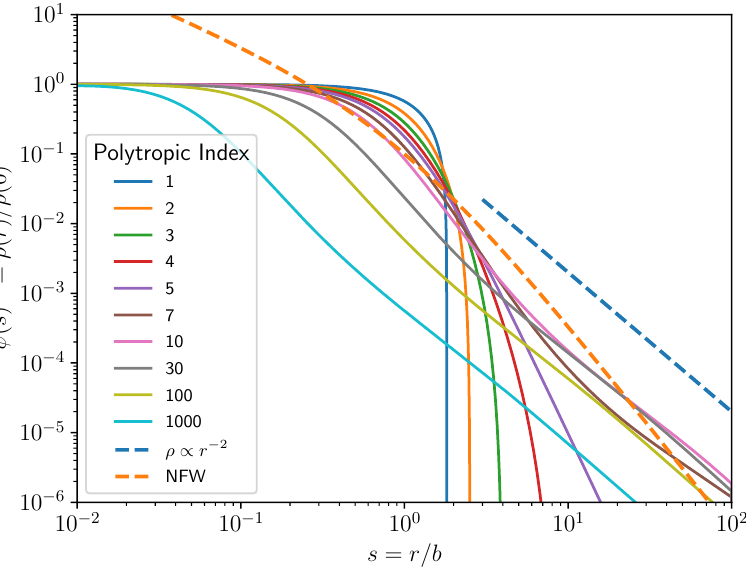
Figure 1. Polytropes resulting from solving the Lane–Emden Equation (21). These curves just provide the shape of the mass density profile, which can be shifted horizontally and vertically by arbitrary amounts (set by the constants b and ρ ( 0 ) , respectively). The color code of the solid lines gives the polytropic index m as indicated in the inset. The curve with m = 1000 approximately corresponds to the shape of an isothermal sphere. For reference, the figure includes ρ ∝ r − 2 (the blue dashed line), which represents the asymptotic behavior of high- m polytropes, and also shows an NFW profile (the orange dashed line)